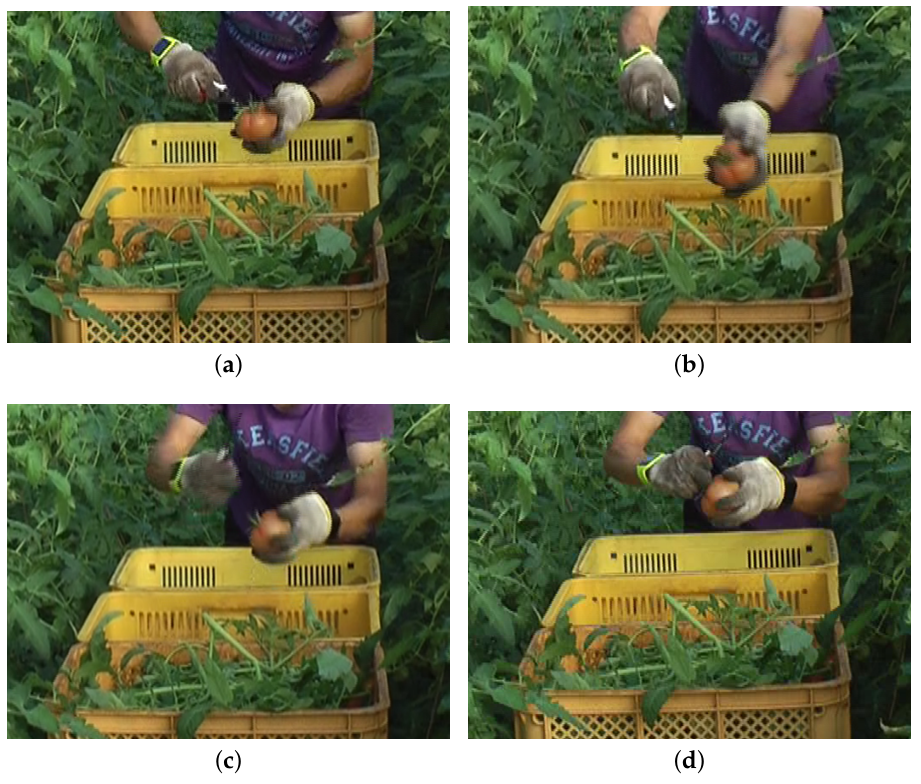
Figure 6. The harvesting action of a farm laborer. A farm laborer holds a tomato in his left hand and is about to cut off the stem of the tomato ( a ). After cutting the stem off, the laborer stretches out both hands to throw the stem into a waste box attached to a cart ( b , c ). As a final action, the laborer brings his hands back to the initial position ( d